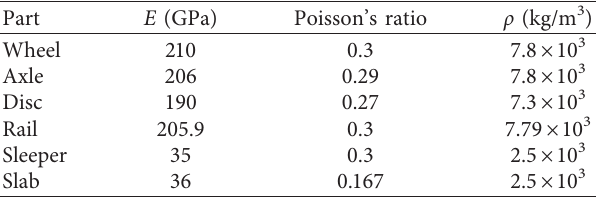
Table 1: Material